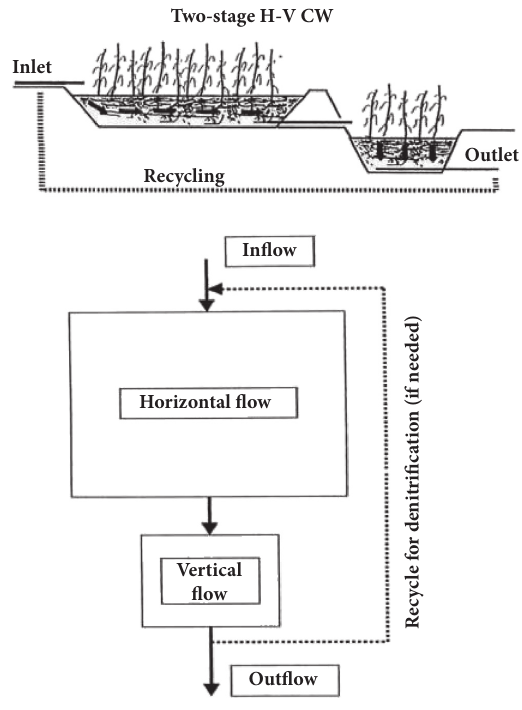
Figure 4: Schematic arrangement of the HF-VF hybrid system according to Brix and Johansen (source: